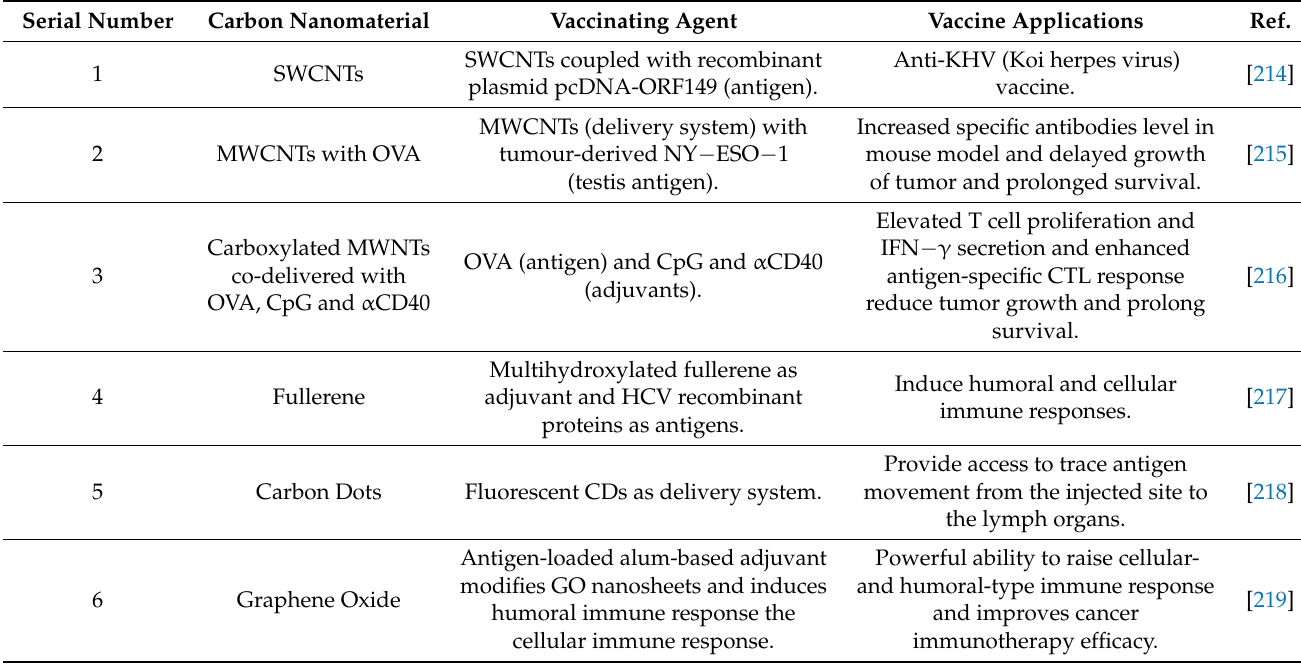
Table 8. Different CNMs’ uses in